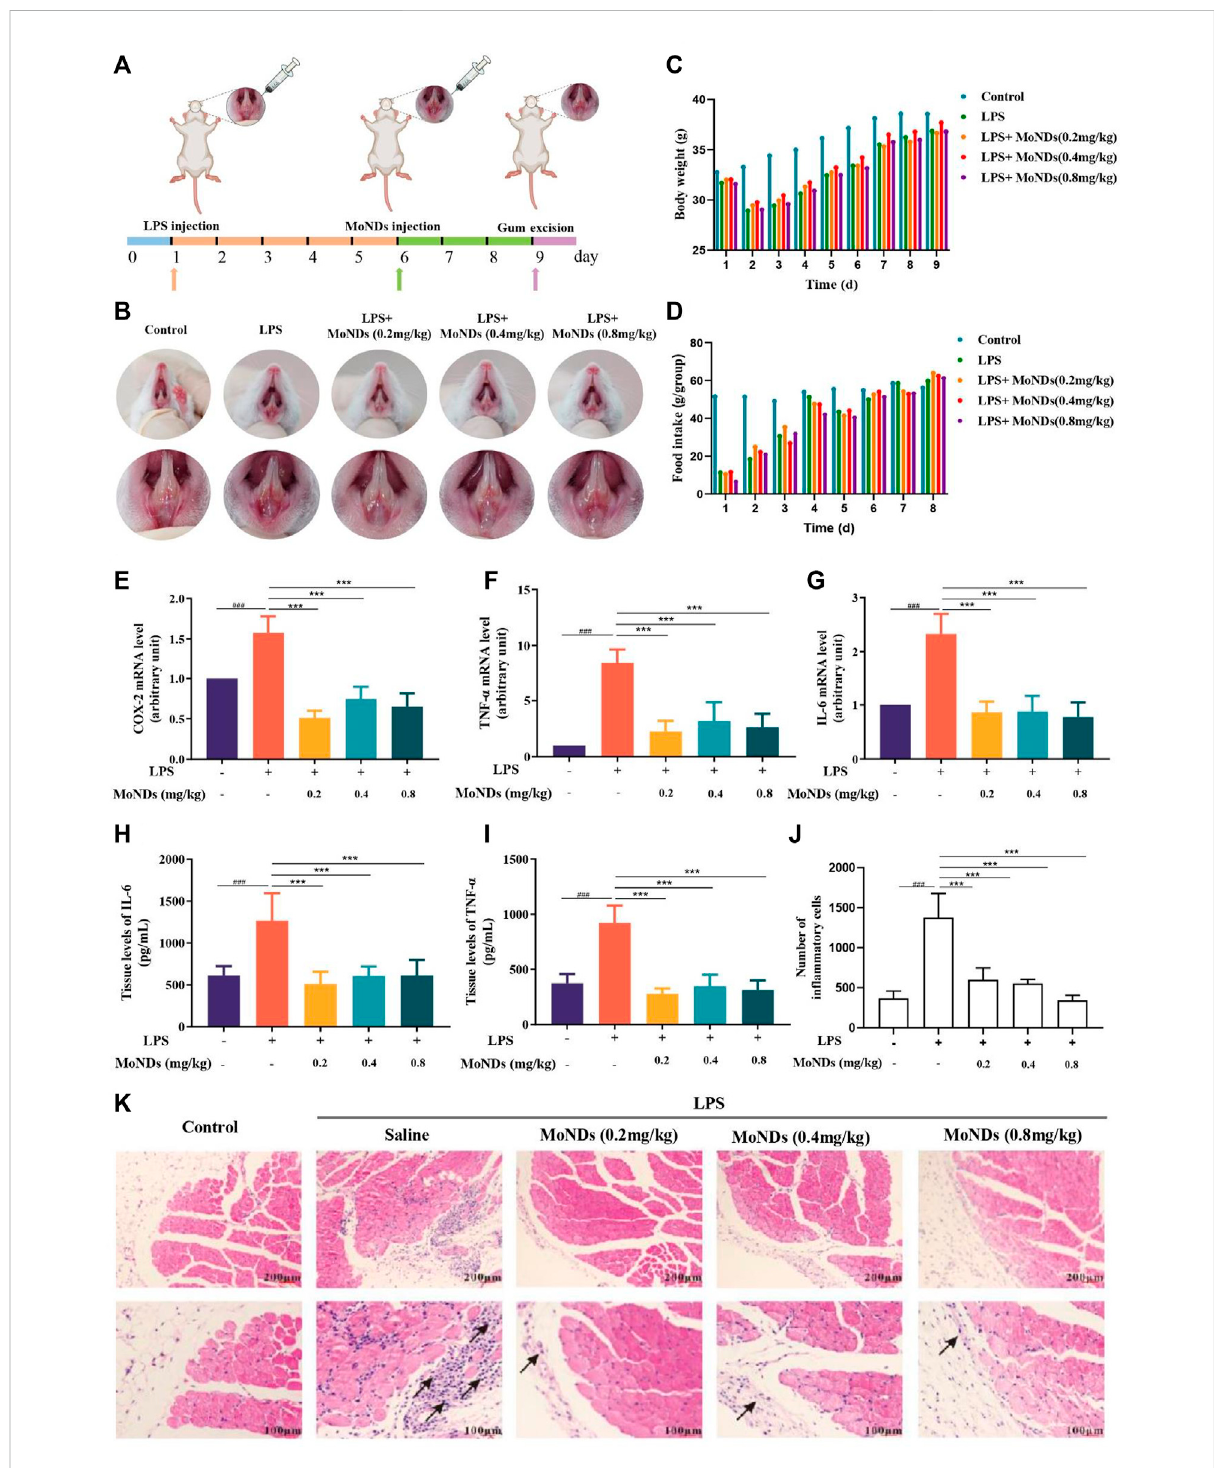
FIGURE 2 Therapeutic effects of MoNDs. (A) Schematic illustration of the establishment and treatment schedule of PD mice. (B) Photographic images of mice 3 days after various treatments. Changes in body weight (C) and food intake (D) of mice in different groups. (E – G) RT-qPCR analysis of the mRNAlevelsofthepro-in fl ammatorymediators(COX-2) (E) ,TNF- α (F) ,andIL-6 (G) ).TheIL-6 (H) andTNF- α (I) ELISAresultsofgingivaltissue. (J) The quantitative statistical results of in fl ammatory cells in HE staining. (K) Representative images of HE staining after MoND treatment. Black arrows indicate the in fl ammatory in fi ltration. Scale bar: 100 μ m and 200 μ